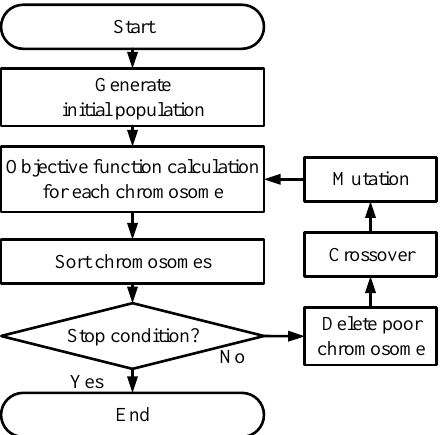
Figure 6. Conventional genetic algorithm (GA) flowchart [26].